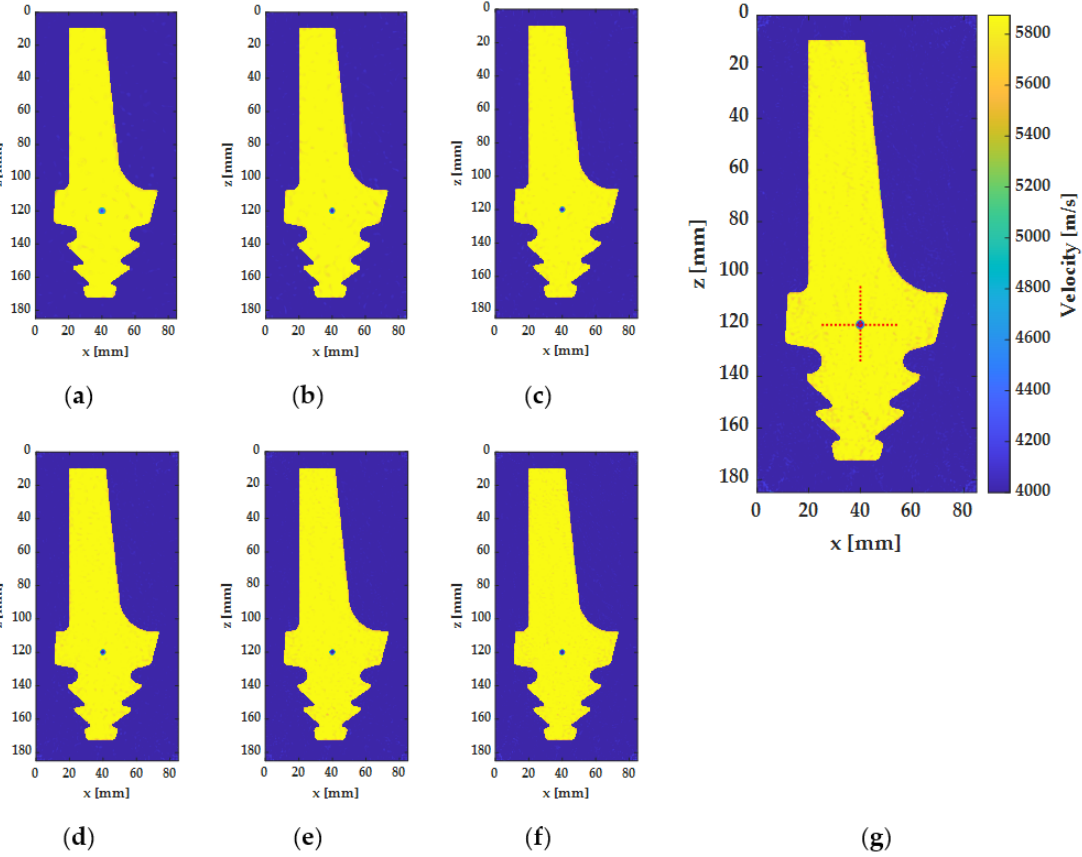
Figure 9. Tomographs of the 3 mm circular hole based on successive-frequency inversions at: ( a ) 0.4 MHz; ( b ) 0.6 MHz; ( c ) 0.8 MHz; ( d ) 1 MHz; ( e ) 1.2 MHz; ( f ) 1.4 MHz; ( g ) 1.6 MHz.